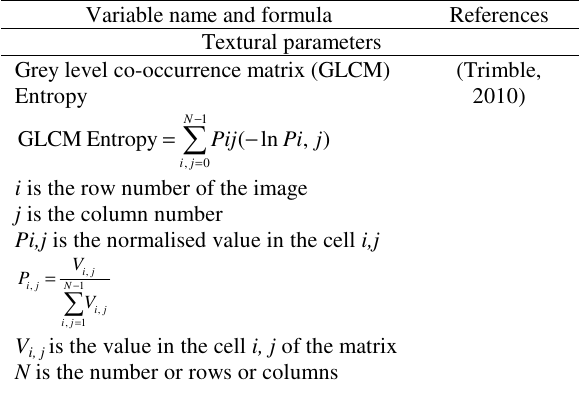
crop, pasture and woody). Overall classification accuracy for summer 2010 was 87% ( k = 0.73)(Table 2) while that of winter 2011 was 93% ( k = 0.9) (